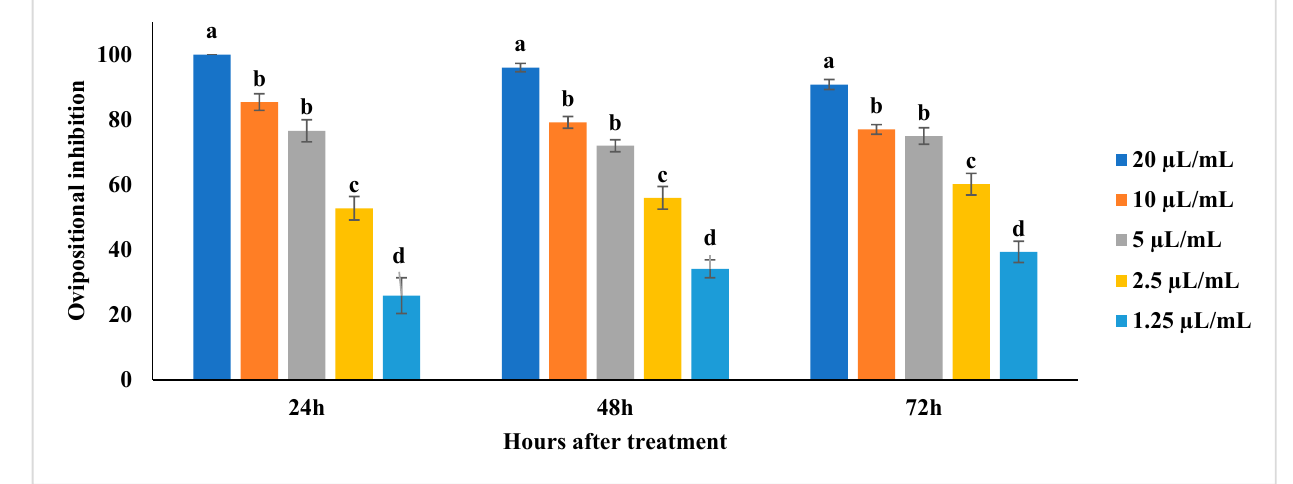
Figure 4. Ovipositional inhibition of Mentha piperita against Callosobruchus chinensis ; Means followed by the same letter within the error bars are not statistically different by Tukey ( p ≤ 0.05).